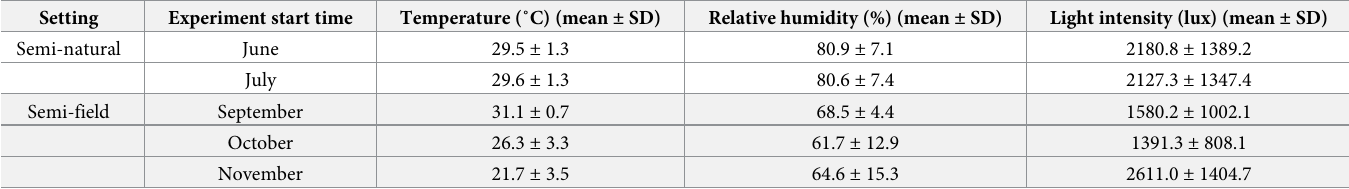
Table 2. Mean air temperature, relative humidity, and light intensity during the adult experiments.